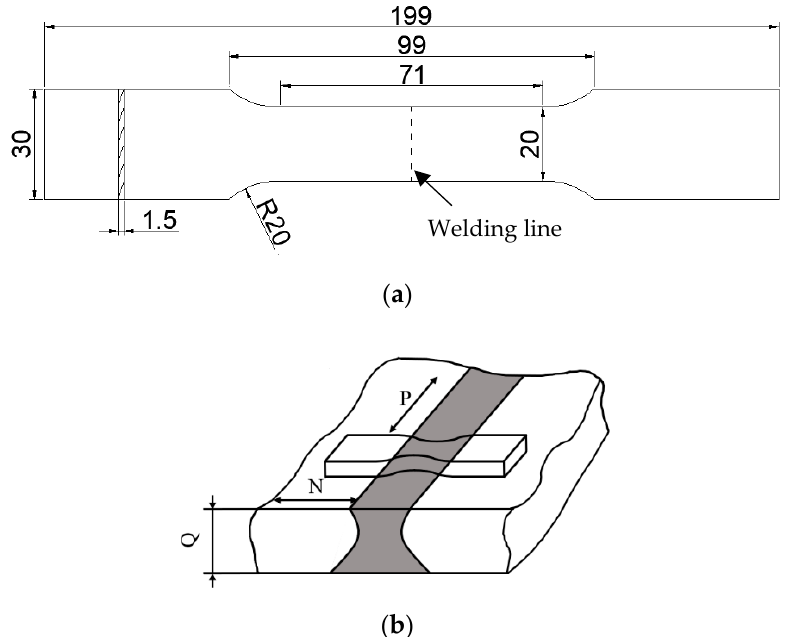
Figure 1. The tensile test specimen: ( a ) the geometry and size of the tensile specimen (unit: mm), ( b ) sampling orientation.